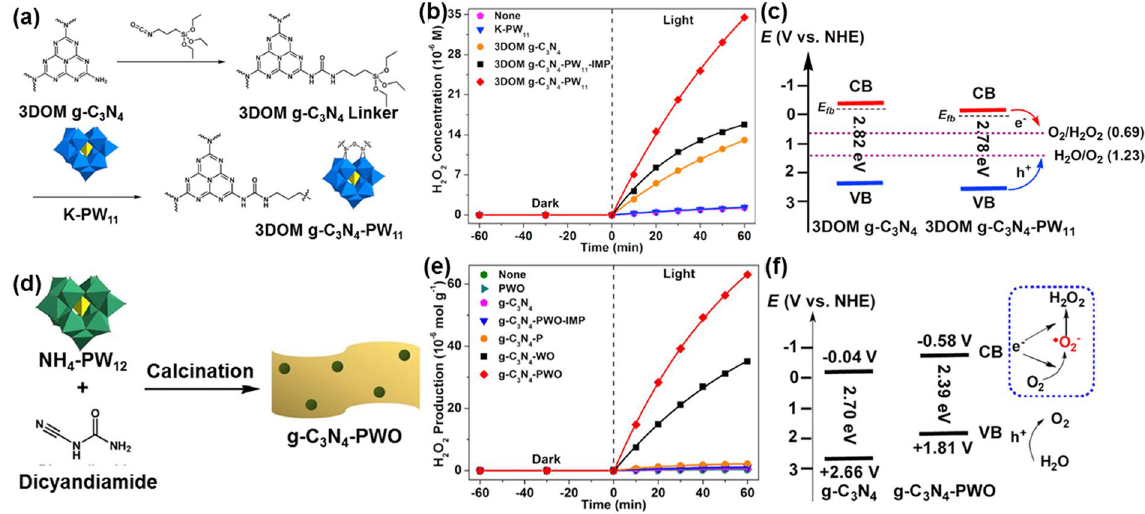
Fig. 5 a, d Schematic illustration of the synthetic route to 3DOM g-C 3 N 4 -PW 11 and g-C 3 N 4 -PWO. b, e H 2 O 2 production over different catalysts in 60 min. c, f Scheme of energy levels and charge transfer pathways of 3DOM g-C 3 N 4 and 3DOM g-C 3 N 4 -PW 11 , g-C 3 N 4 and g-C 3 N 4